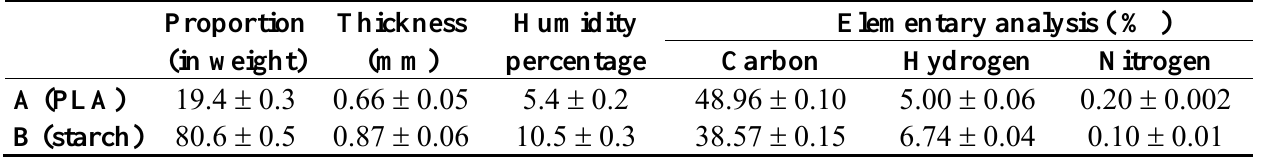
Table 1. Main characteristics of the A (PLA) and B (starch) parts of the co-extruded film A/B/A .